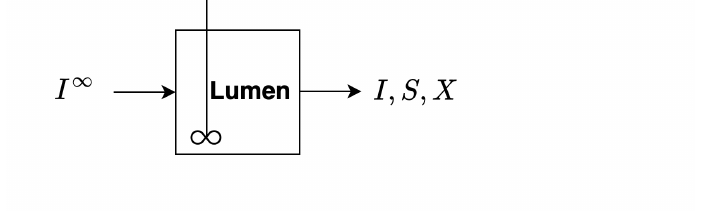
Figure 1. The reactor representation of the single compartment model. The compartment is fully mixed. There is inflow of fiber ( I ∞ ) and outflow of fiber ( I ), sugar ( S ) and biomass ( X